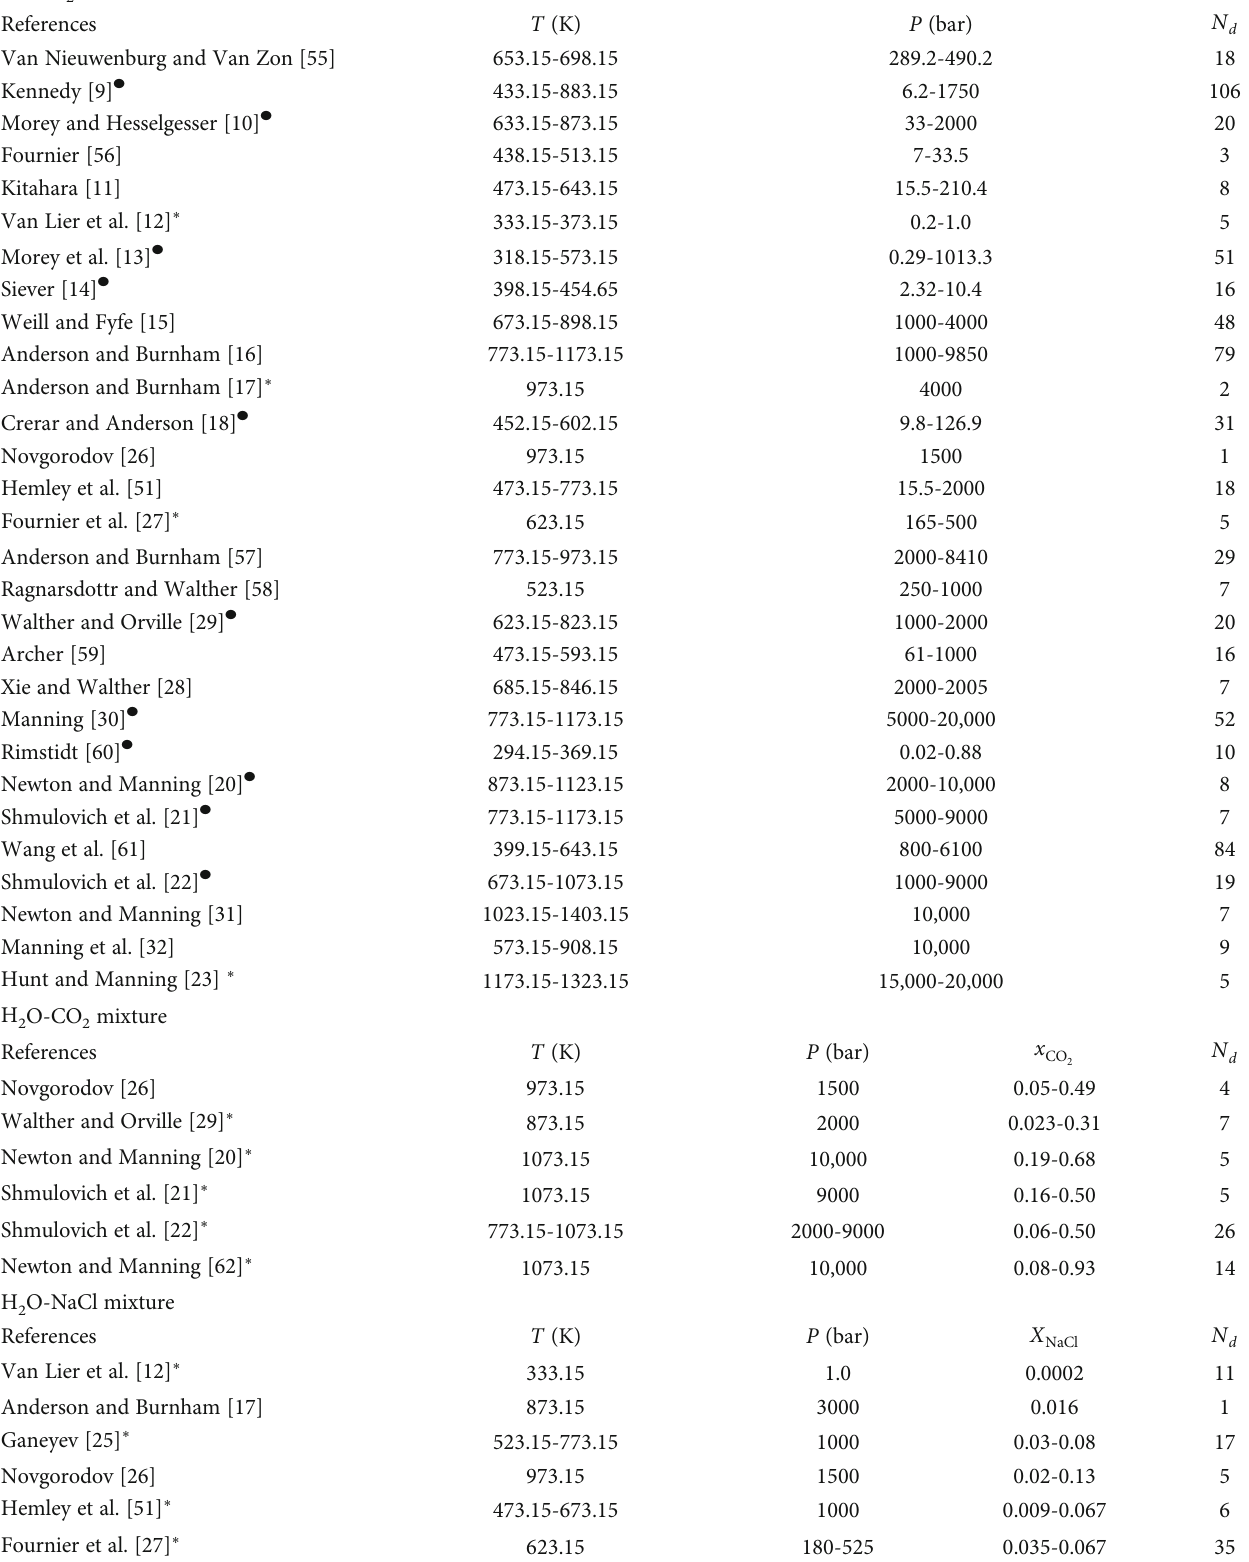
Table 1: Experimental measurements for quartz